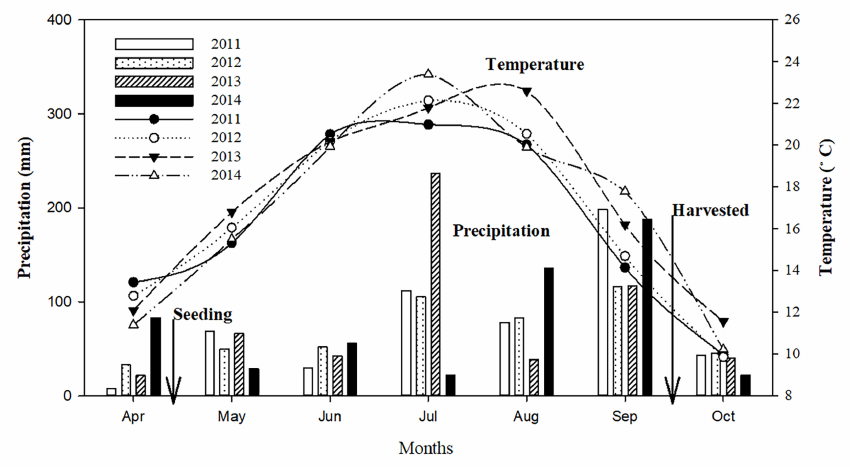
Figure 2. Dynamic change in monthly temperature and precipitation in four continuous growing